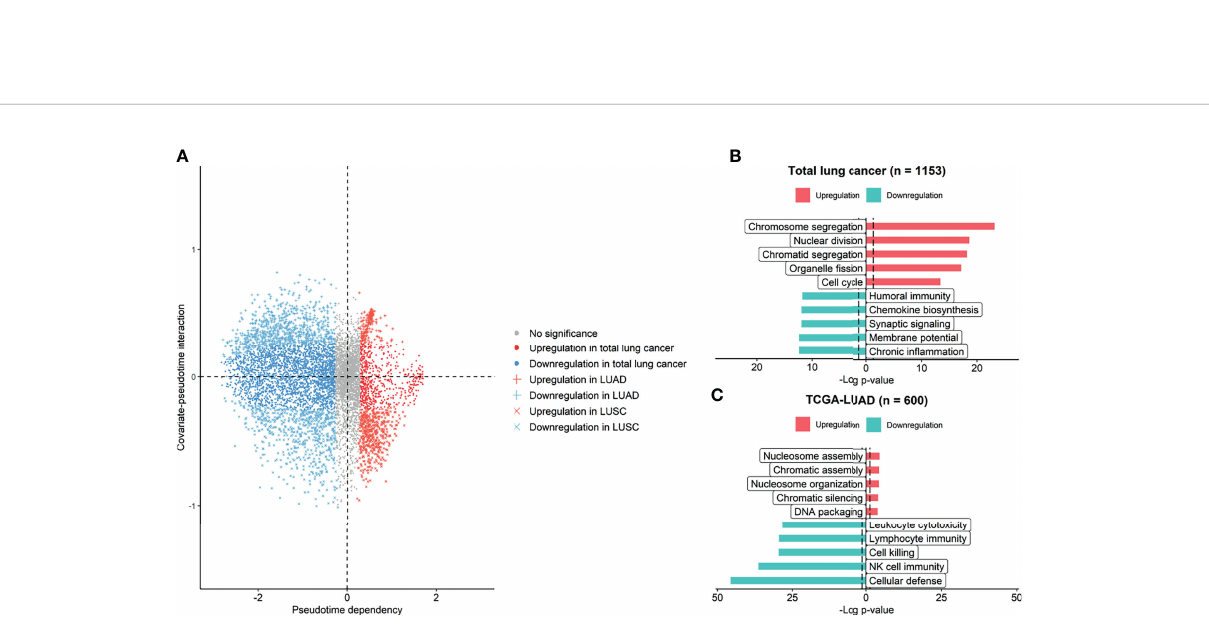
FIGURE 3 | Survival curves according to pseudotime. Survival analyses were performed in two groups divided by cutoff values of pseudotime which were explored using the “ cutoff ” package in R. (A) Disease-free survival was signi fi cantly different between the two groups. (B) Overall survival was signi fi cantly different between the two